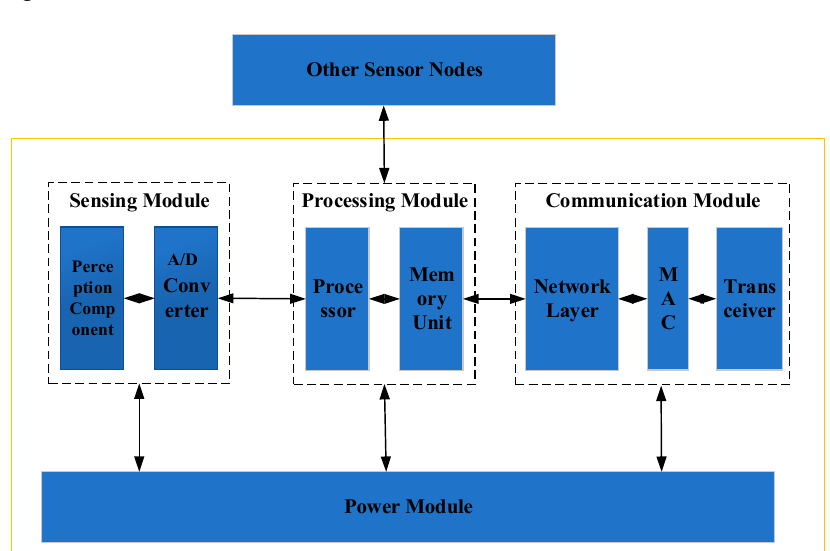
Figure 1. Framework of wireless sensor network.